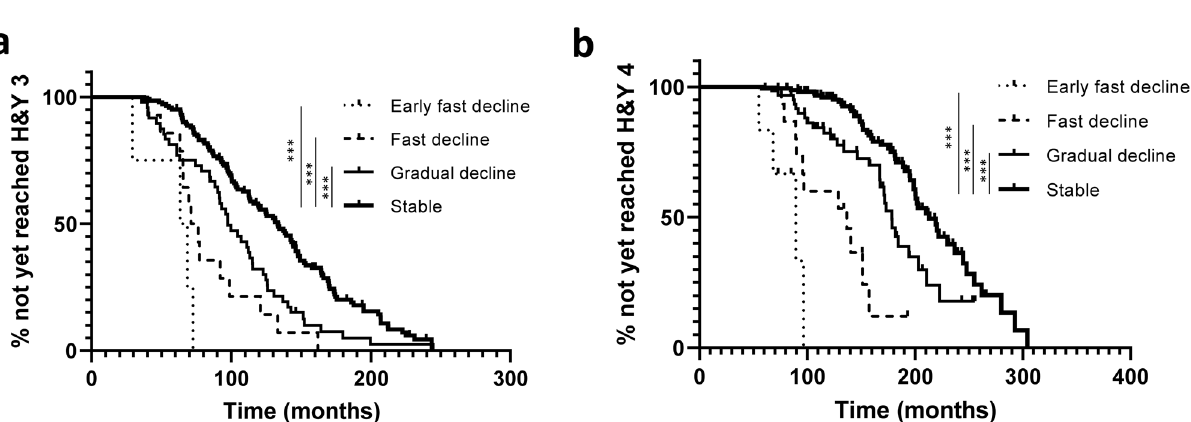
Figure 4. Progression of Hoehn and Yahr (H&Y) stage according to cognitive trajectories. ( a ) Kaplan–Meier curves for motor progression from diagnosis to the onset of H&Y stage 3 according to cognitive trajectories. ( b ) Kaplan–Meier curves for motor progression from diagnosis to the onset of H&Y stage 4 according to cognitive trajectories. *** p <